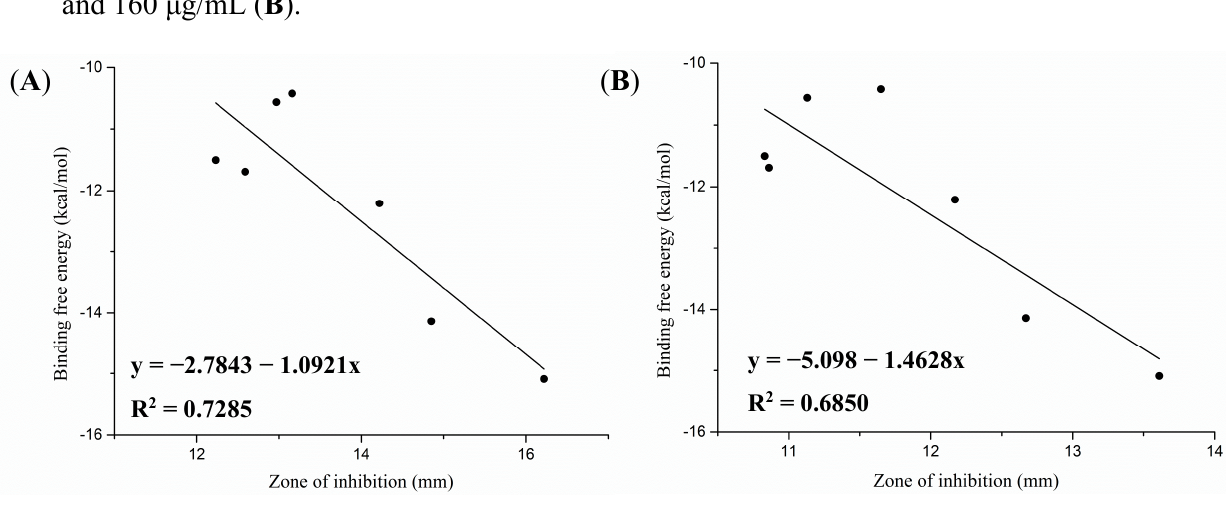
Figure 4. Correlation between binding free energy ( Δ Gb, kcal/mol) and antibacterial activity (zone of inhibition; mm) against E. coli . for scereened compounds with 320 μ g/mL ( A ) and 160 μ g/mL ( B